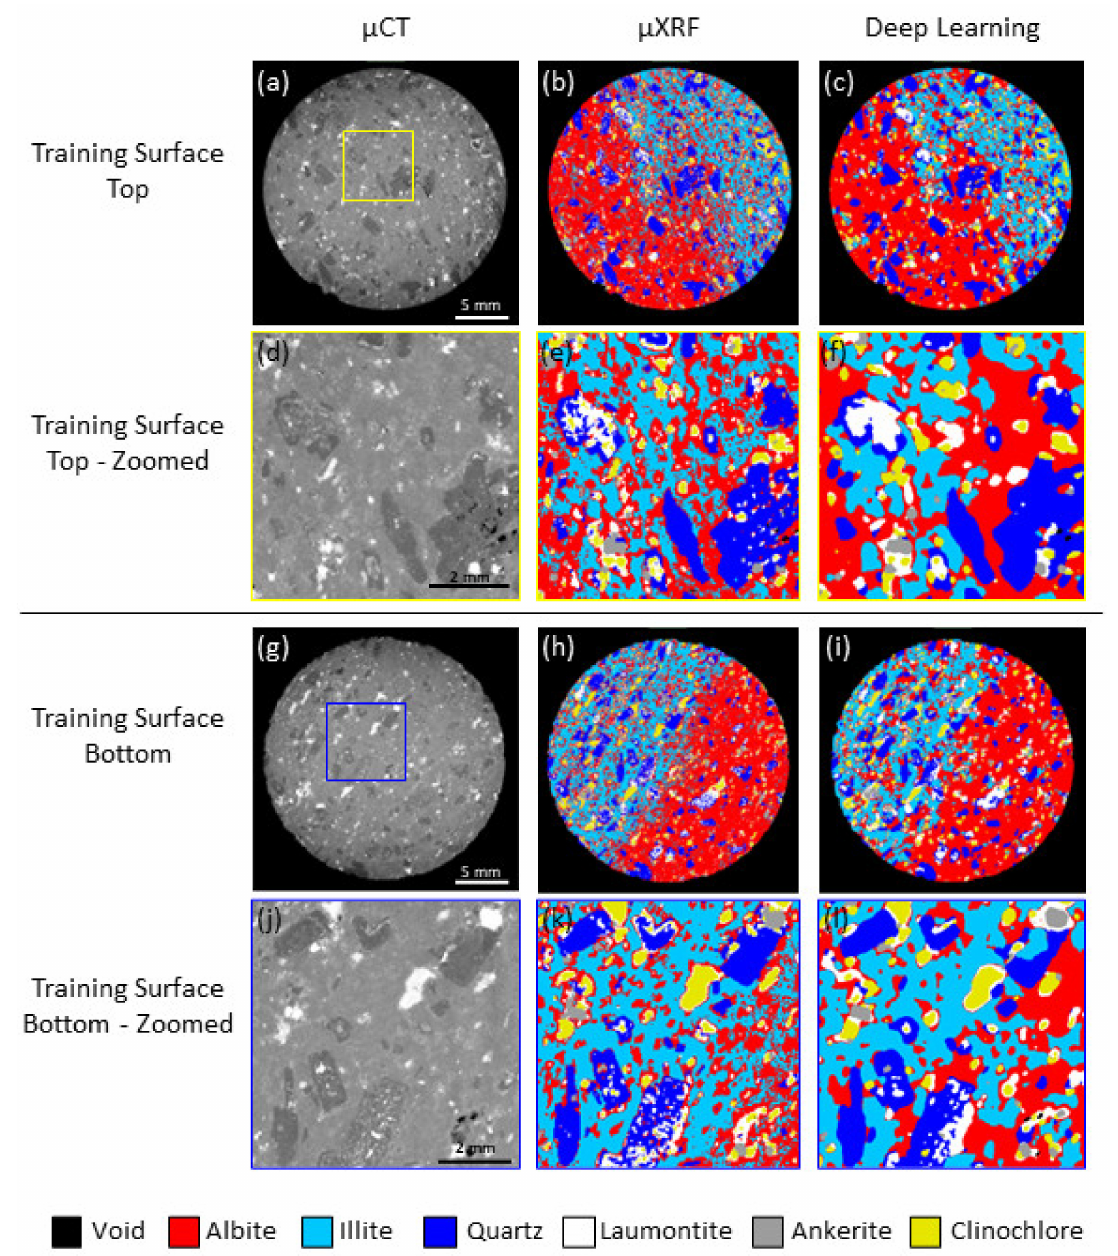
Figure 6. Training data from the top surface for ( a ) µ CT data; ( b ) µ XRF from K-means clustering; ( c ) deep learning segmentation; ( d – f ) zoomed areas as defined by the yellow inset box, respectively. The training data from the bottom surface is shown for ( g ) µ CT data; ( h ) µ XRF from K-means clustering; ( i ) deep learning segmentation; ( j – l ) zoomed areas as defined by the blue inset box,